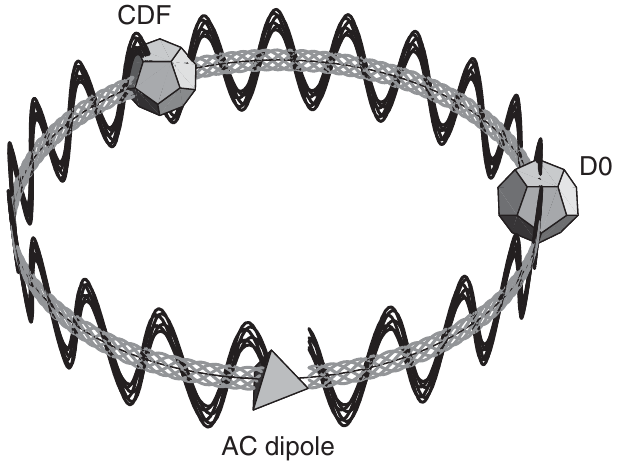
FIG. 1. Schematic of incoherent free oscillations (gray) and excited coherent oscillations (black) of charged particles in the Tevatron. Because individual particles within the beam oscillate incoherently, coherent oscillations must be excited to observe the betatron oscillations and measure parameters such as the (cid:1) function. An AC dipole is one of such tools to excite coherent oscillations of the